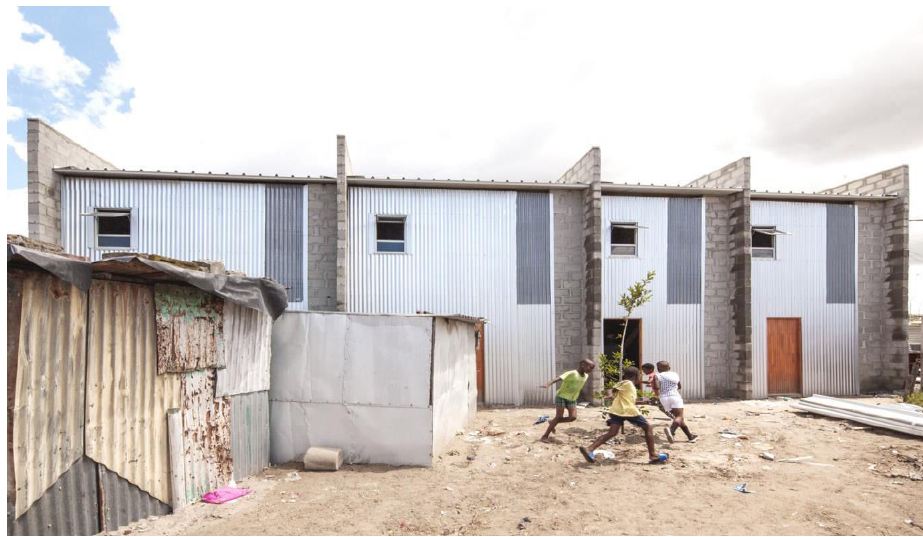
Figure 6: Phase three of Urban Think Tank's Empower Shack prototype in Khayelitsha, South Africa. Dezeen.com,